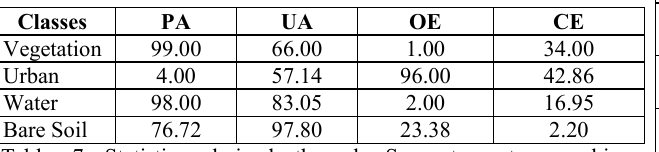
Table 7 Statistics derived through Support vector machine